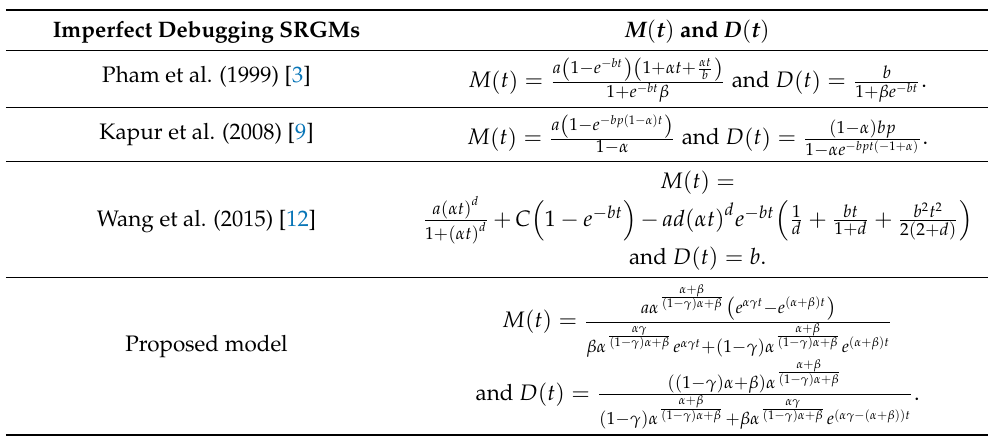
Table 4. Summary of Mean Value Function and Error Detection Rate Functions for the Imperfect Debugging